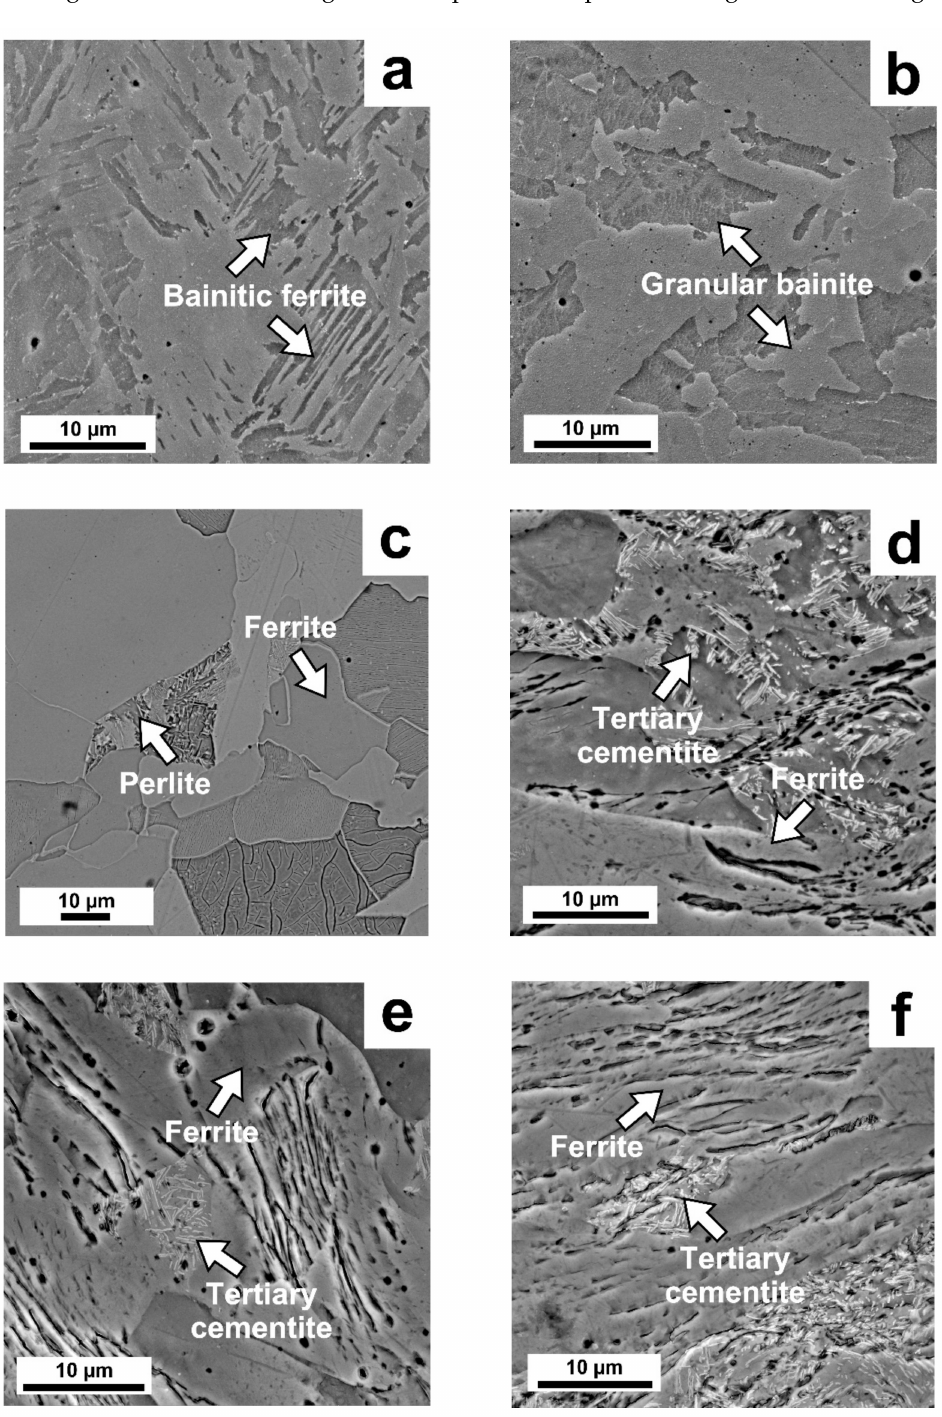
Figure 4. Microstructure of steel 09CrNi2MoCu in various states: ( a ) Initial state after DLD; ( b ) Mode 1 (DLD + HT); ( c ) Mode 2 (DLD + HT); ( d ) 50% degree of deformation compression; ( e ) 60% degree of deformation compression; ( f ) 70% degree of deformation